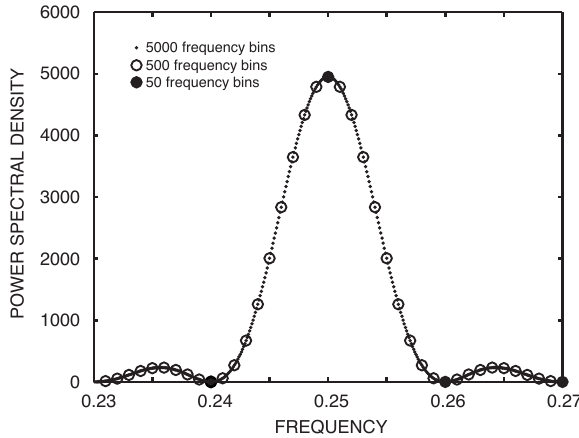
Fig. 1. Power spectrum of a signal at three different resolutions. The frequency of the sinusoidal signal is one fourth of the sampling frequency, and the sample sequence consists of 100 samples. The number of equidistant frequency bins within the frequency interval 0–0.5 is 50, 500 and 5000,